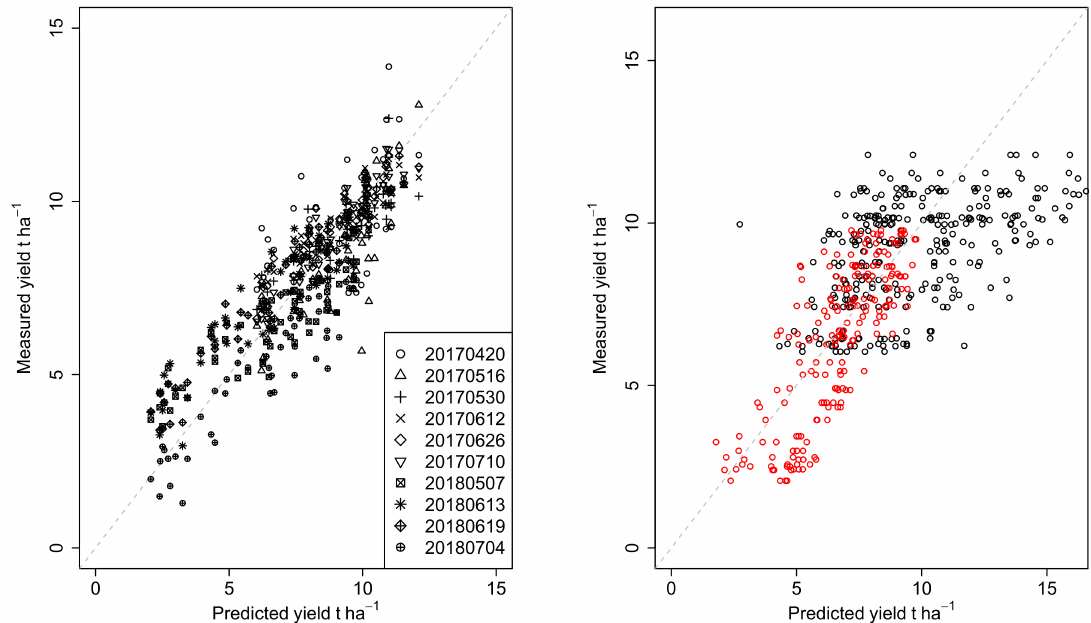
Figure 5. Measured yield (t ha − 1 ) plotted against predicted yield (t ha − 1 ) from a linear model fit to LAI, height and time (day of year). The left panel shows the results using a 10-fold cross-validation. The symbols show the independent validation comparison against 10% of the data for 10 model fits on the remaining 90% of the data. The symbols indicate the date (YYYYMMDD) of data collection for LAI and height for each individual validation. The right panel shows the results of a validation using one year/location for calibration and the other for validation. The red symbols are for the model fit on 2017 data and validated on 2018; the black symbols show the validation on 2017 data using a fit on 2018 data. Dashed lines are